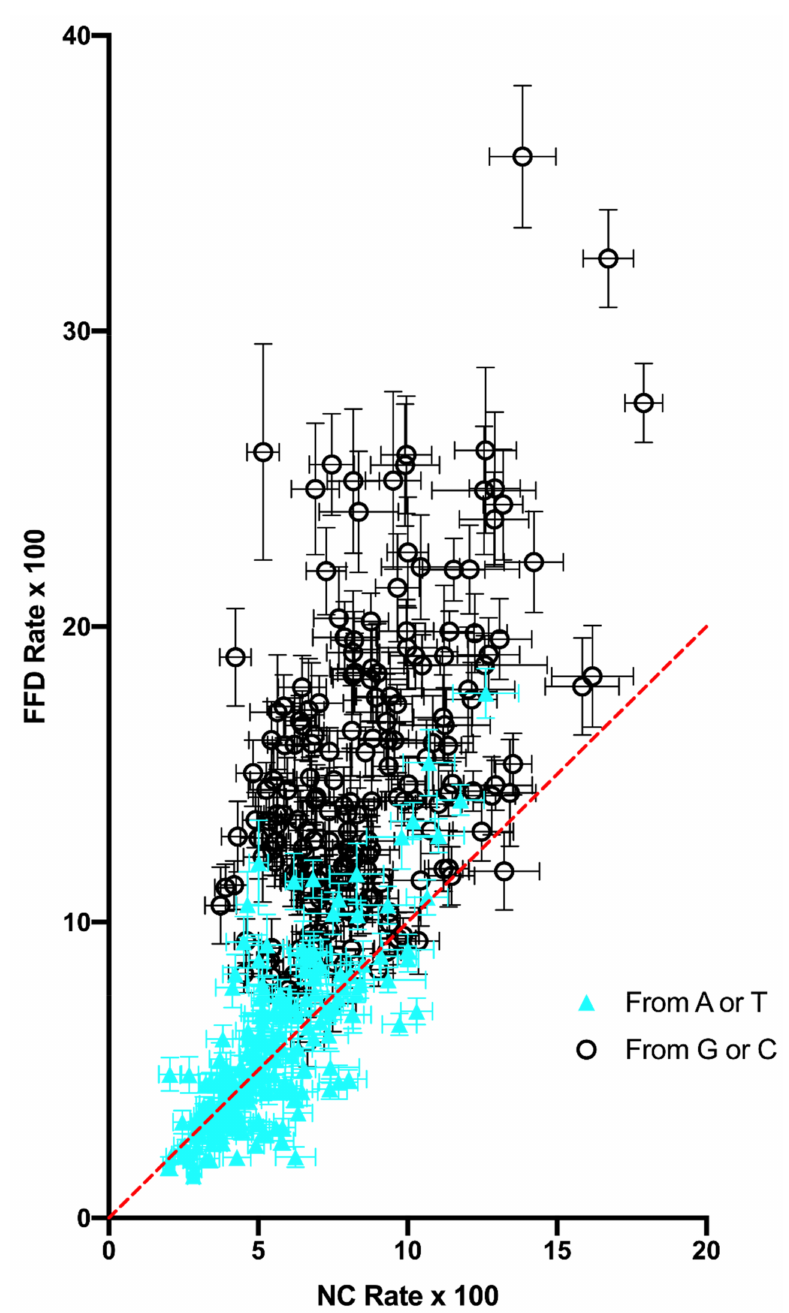
Figure 1. Rate of substitution of FFD and NC sites of each nucleotide within each tetranucleotide context. Rate for each matrix row is calculated as the number of off-diagonals in that row divided by the row total. Substitution rates from A or T (closed blue triangles) are higher in FFD in 96 of 192 contexts, while substitution rates from G or C (black circles) are higher in FFD in 184 of 192 contexts. The equality line is drawn in